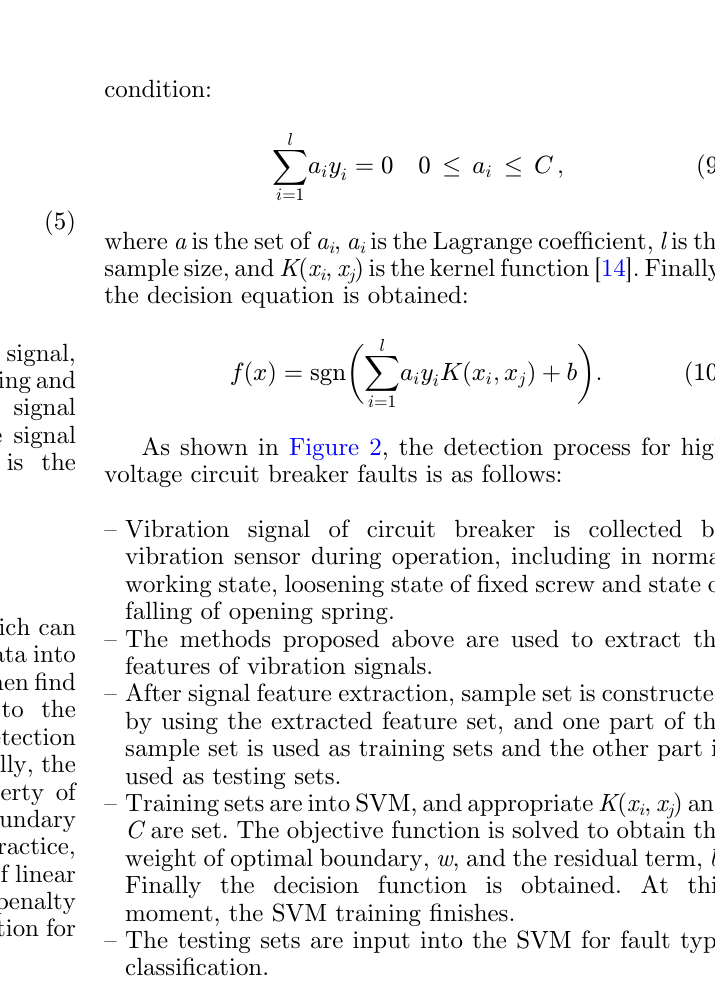
Fig. 2. The fl ow of circuit breaker fault detection based